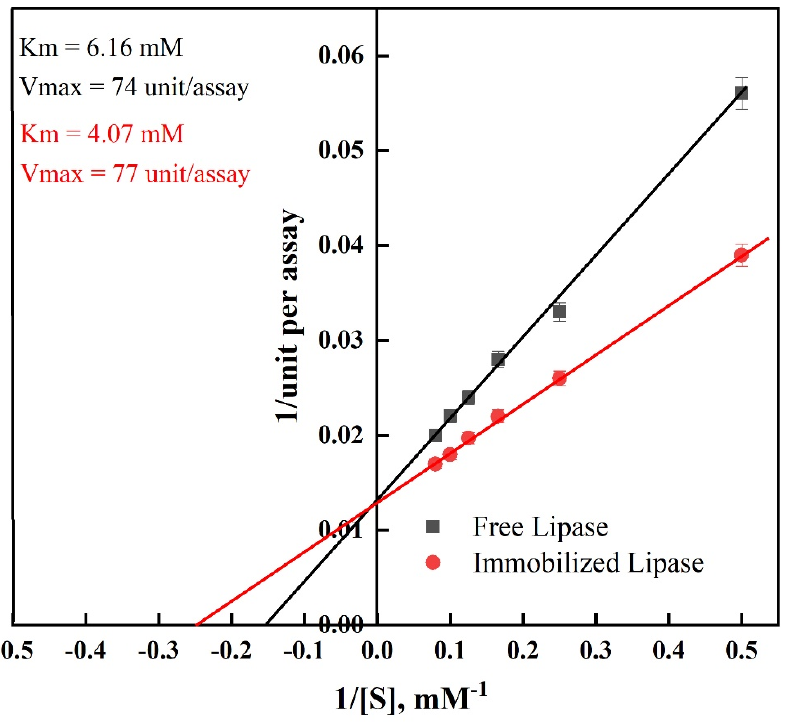
Figure 6. Kinetic parameters of free and immobilized